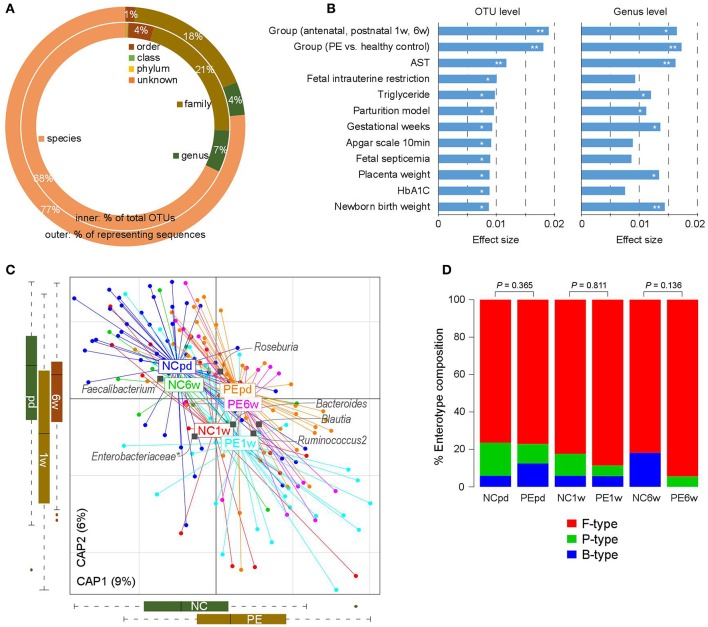
Overview of the gut microbial community in PE patients and healthy controls. (A) Summary of the taxonomic assignment of the OTUs. Inner circle, the percentage of OTUs that assigned into a taxon at the species, genus, family, order, class, and phylum levels. Outer circle, the percentage of representing sequences of the OTUs at all taxonomic levels. (B) Host factors that significantly affected the gut microbiota. The 12 factors associated with the variation of the gut microbiota at the OTU level are shown. Bar plots indicate the explained variation (effect size) of each factor at the OTU level (left panel) and genus level (right panel). **, permutated P < 0.01; *, permutated P < 0.05. (C) dbRDA plot based on the Bray-Curtis distances between microbial genera, revealing PE microbial dysbiosis at the antepartum, 1 and 6 weeks postpartum periods. Patient and control samples were mainly separated in the primary constrained axis (PE separation), and samples at different time points were mainly separated in the second constrained axis (time point separation). Lines connect samples (colored points) in the same group, and circles cover samples near the center of gravity for each group. Genera (yellow squares) as the main contributors are plotted by their loadings in these two components. (D) Constitution of enterotypes in all groups. P-values between PE patients and healthy controls at three time points were calculated based on Fisher's exact test.